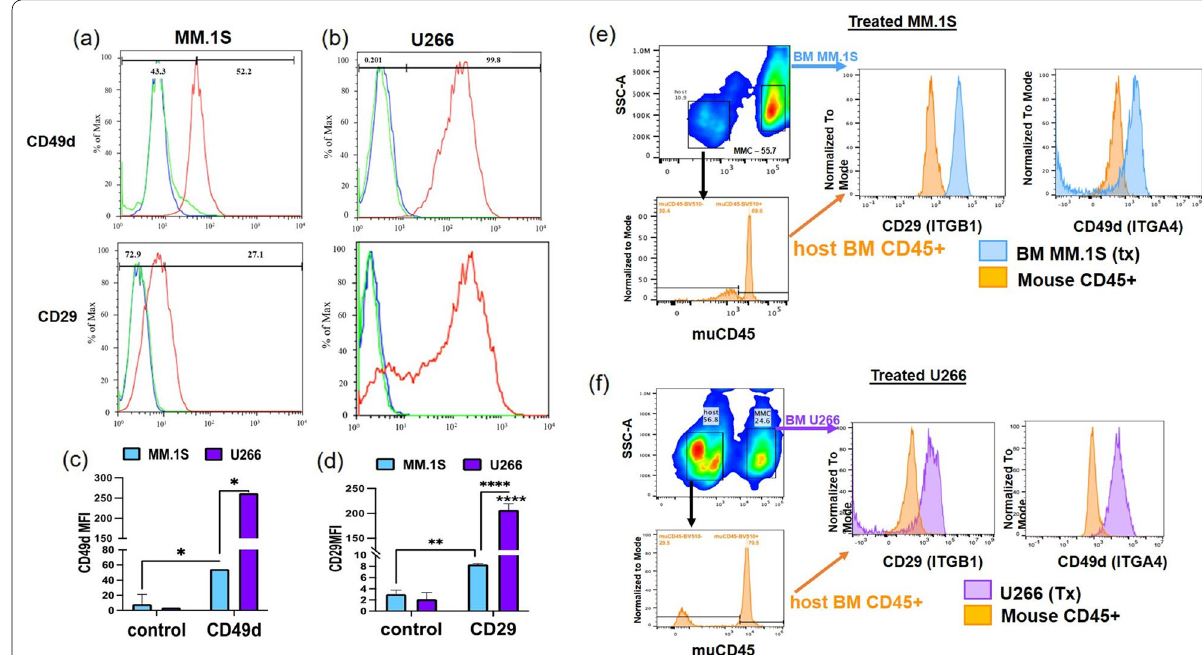
Fig. 5 Representative CD49d/α 4 (upper panel) and CD29/β 1 (lower panel) surface expression levels in a MM.1S, b U266 cell lines analyzed by flow cytometry. c Comparison of CD49d mean fluorescence intensity (MFI) values among MM.1S and U266 cell lines. The non-specific surface binding was evaluated by isotype (IgG) controls. d Comparison of CD29 MFI values among MM.1S and U266 cell lines. Representative CD49d/α 4 and CD29/